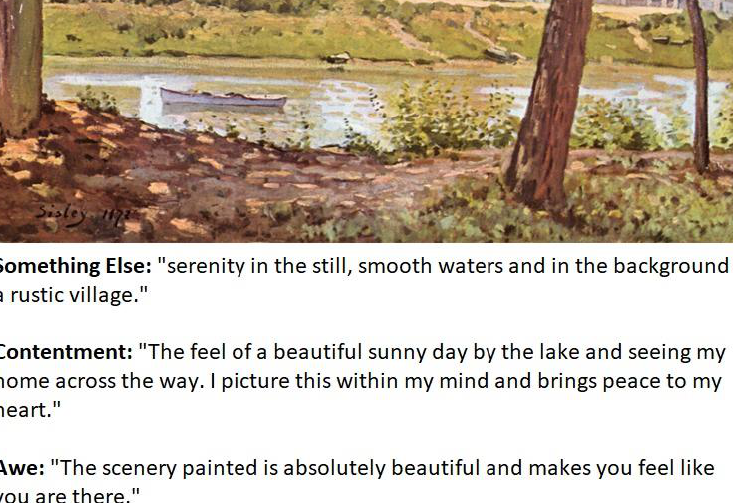
Figure 1. An example from the ArtEmis dataset containing multiple emotional responses for the same artwork. You can see the different descriptions along with their corresponding emotional class (in bold font).